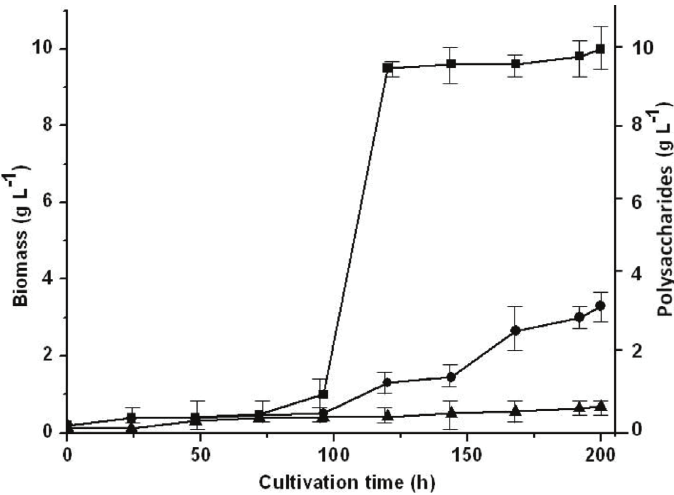
Fig. 4 – Batch cultivation of Ganoderma lucidum ■ biomass; ● intracellular; ▲extracellular